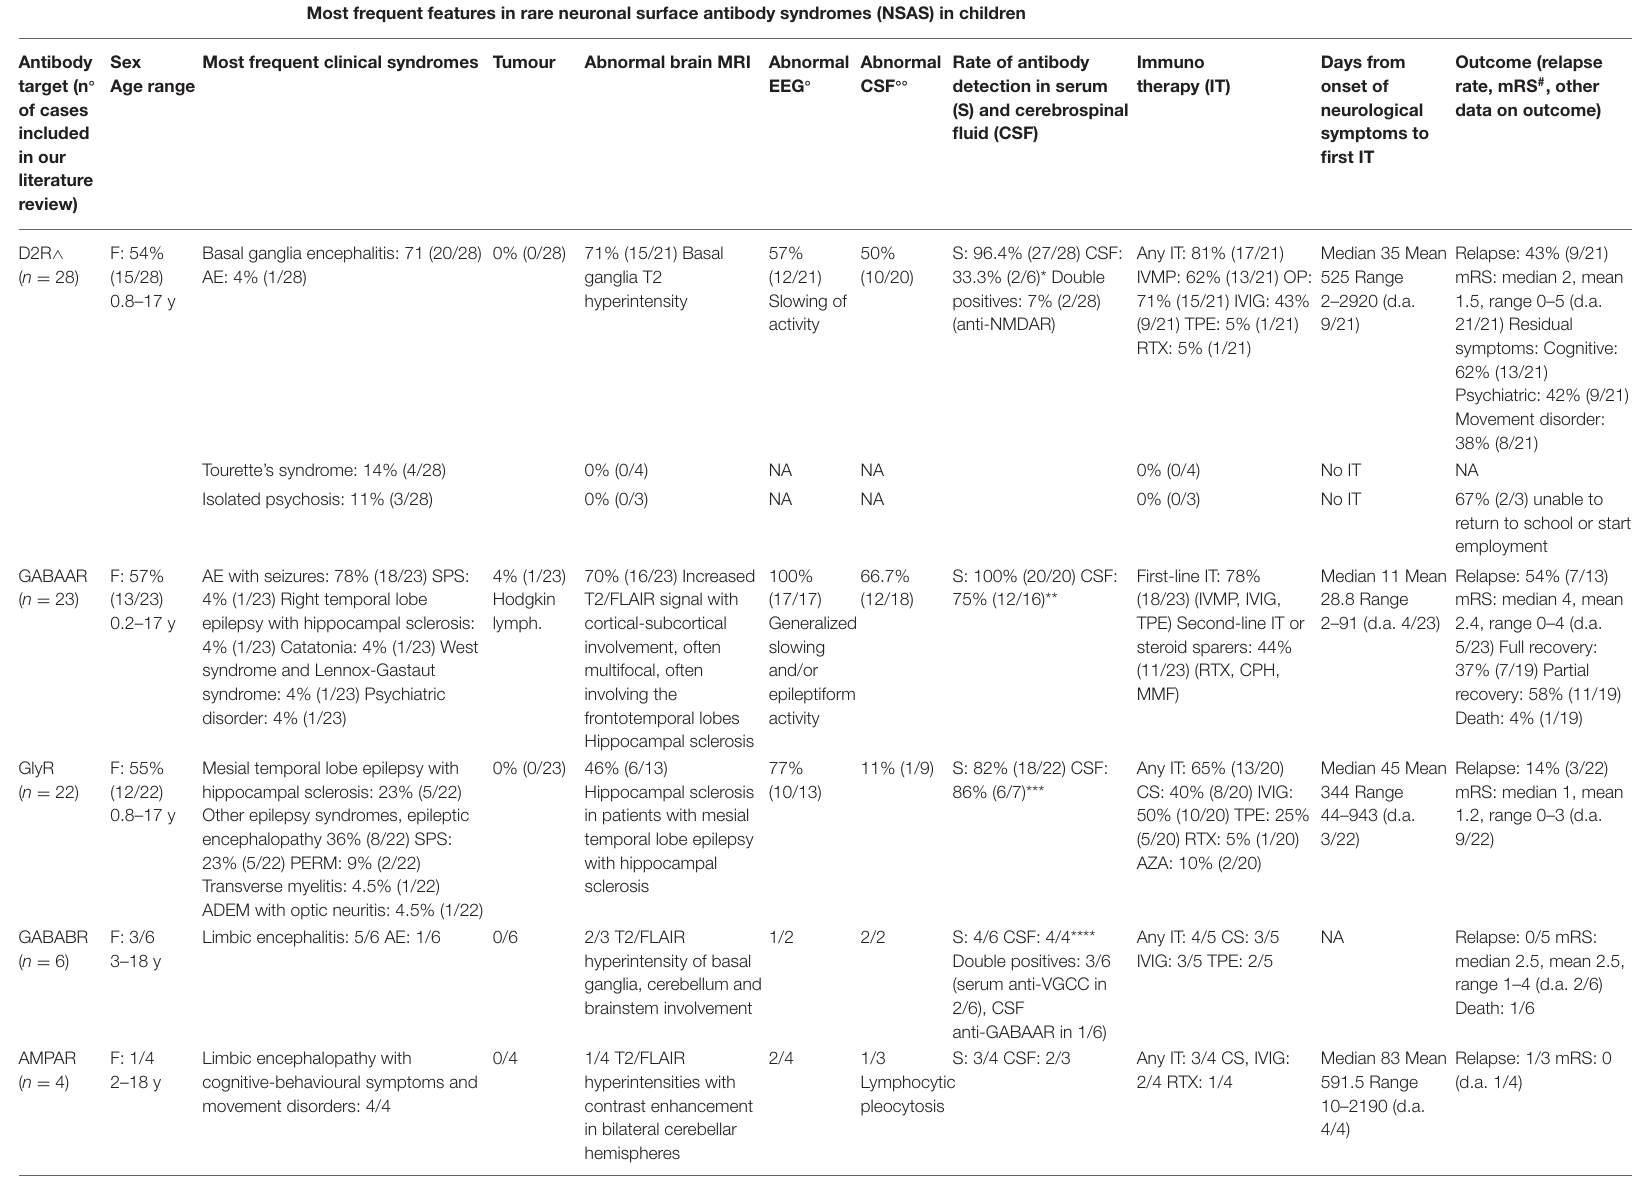
TABLE 1 | Most frequent features associated with rare NSAS in paediatric age according to our systematic literature review (antibodies targeting D2R, GABAAR, GlyR, GABABR, AMPAR, amphiphysin, mGluR5, mGluR1, DPPX, IgLON5, and neurexin-3alpha). Most frequent features in rare neuronal surface antibody syndromes (NSAS) in